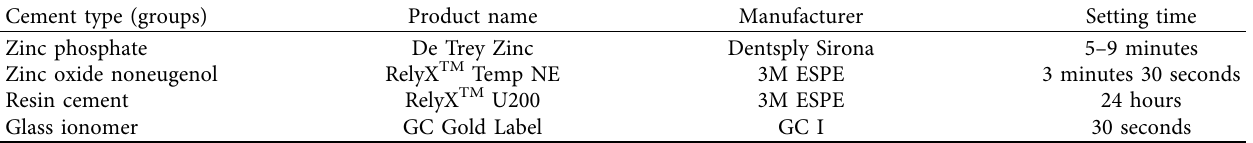
Table 1: Dental cement